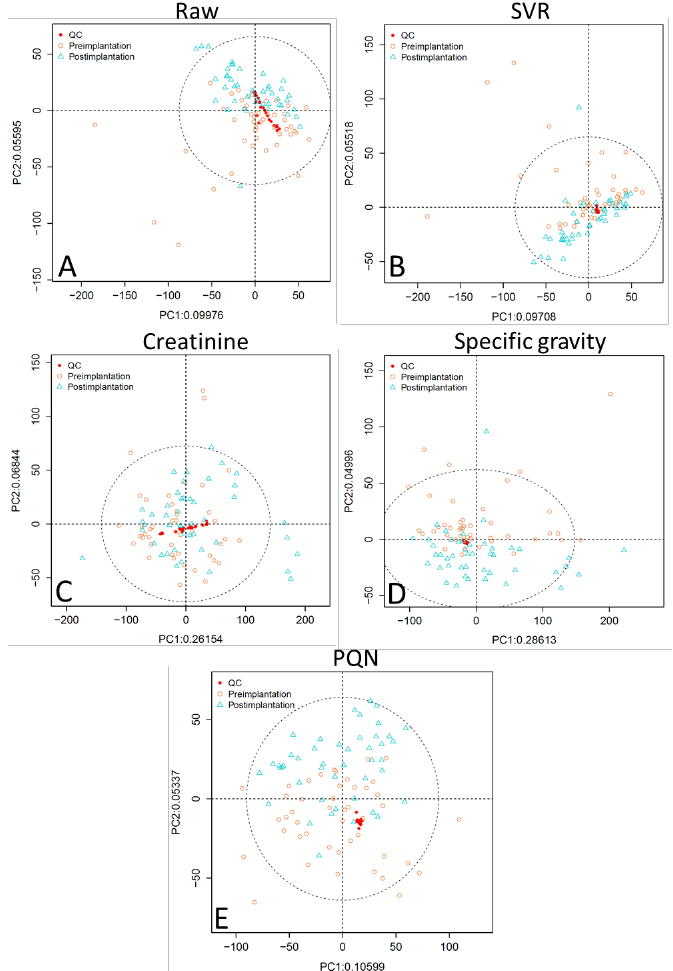
Figure 1. Unsupervised PCA plots comparing normalization approaches for RPLC data showing ( A ) raw data, ( B ) SVR-normalized data, ( C ) SVR and creatinine-normalized data, ( D ) SVR and specific gravity-normalized data, and ( E ) SVR and PQN-normalized data. Abbreviations: RPLC, reversed-phase liquid chromatography; SVR, support vector regression; PQN, probabilistic quotient normalization; PC1, principal component 1; PC2, principal component 2; ellipse is a 95% confidence ellipse.